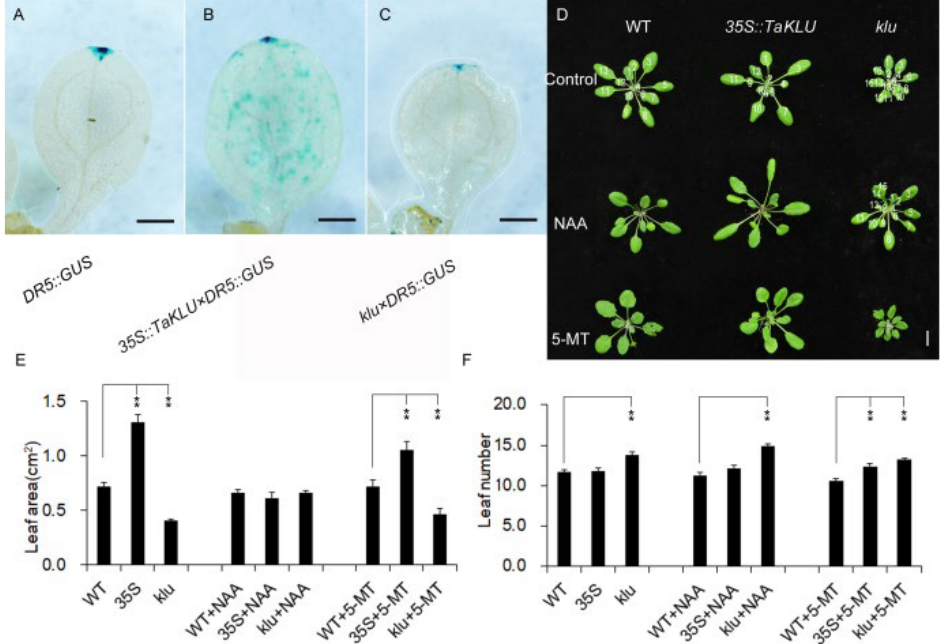
Figure 5. TaKLU regulated the accumulation and response of auxin in leaves. ( A – C ) DR5:GUS marker was used to detect the auxin accumulation in DR5:GUS ( A ), 35S::TaKLU × DR5:GUS hybrids ( B ) and klu × DR5:GUS hybrids ( C ). After resistance screening, the positive hybrids were planted in the same environment with the control groups. Cotyledons of different genotypes Arabidopsis were taken for GUS staining at two weeks post-germination. ( D ) Responses of WT, 35S::TaKLU and klu mutant plants to 1-Naphthaleneacetic acid (NAA) and the auxin synthesis inhibitor 5-methyl-tryptophan (5-MT) treatment. Individual plants ( n > 24) at the same developmental stage were selected for treatment according to previous reports [33]. ( E , F ) Statistics on the leaf area ( E ), n > 10) and leaf number ( F ), ( n > 9) of WT, 35S::TaKLU and klu mutant plants. Size bars represent 200 µ m ( A – C ) and 1 cm ( D ). Bars indicate SE. Asterisks (**) indicate significant differences from their WT at p < 0.01 ( t